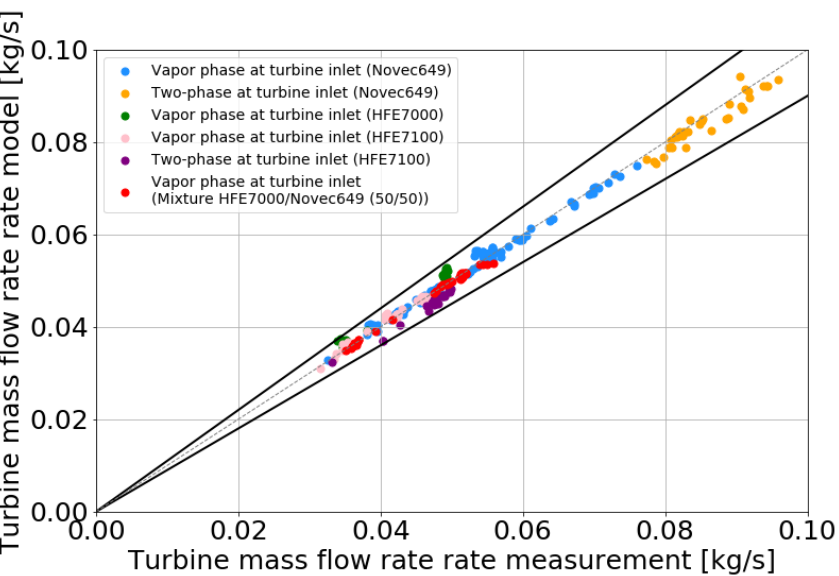
Figure 14. Turbine mass flow rate model vs. turbine mass flow rate measurement.